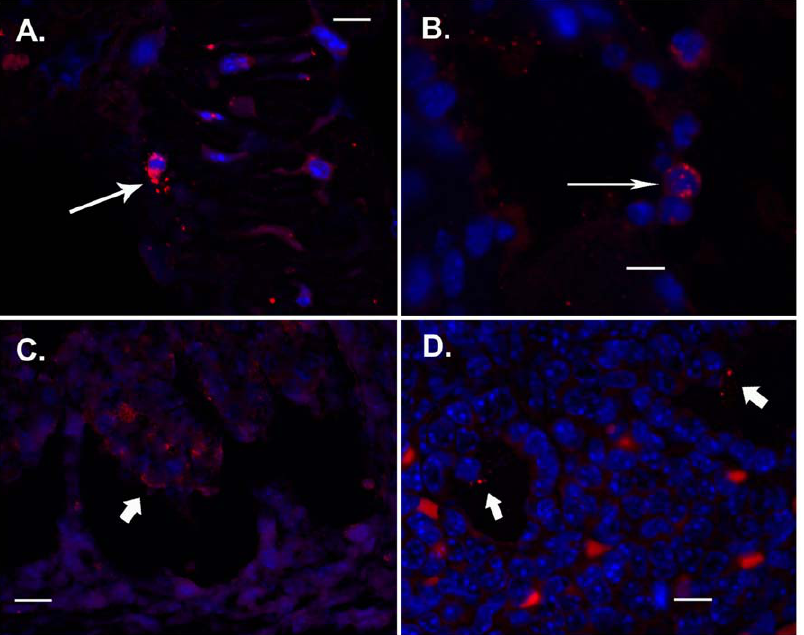
Figure 1. Insitu detection of U.parvum in placental and fetal tissues. Representative 2D projection images (600 x magnifications) of placental choriodecidual junction (A), vitelline membrane (B), fetal intestine (C), and fetal lung (D). Scale bars are equivalent to 100 m m. U. parvum (red) was initially labeled with rabbit polyclonal antibody as previously described [69,71]. Cell nuclei (blue) were labeled with DAPI. Long arrows (A and B) are highlighting U. parvum engulfed by polymorphonuclear cells. Block arrows (D and E) are highlighting epicellular U. parvum .